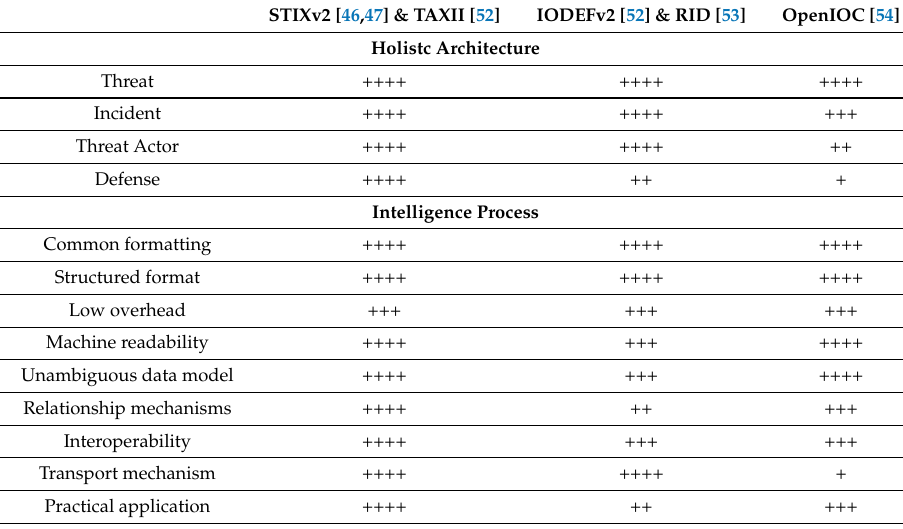
Table 5. Evaluation of TI standards.